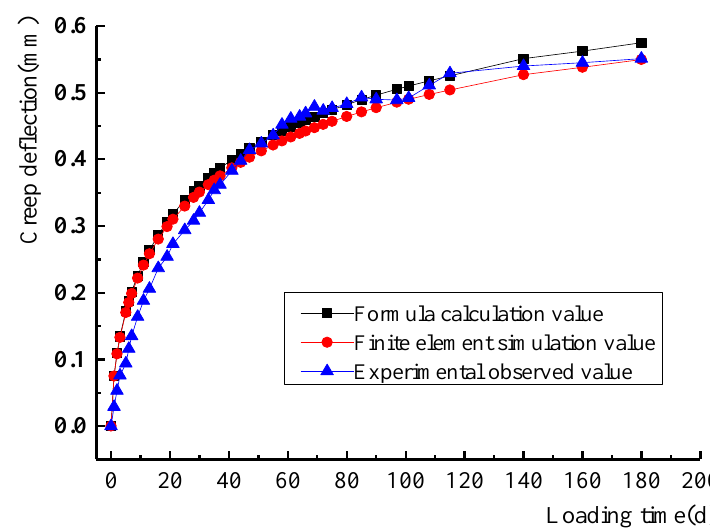
Figure 6. Creep-time curve of specimen TBB1.